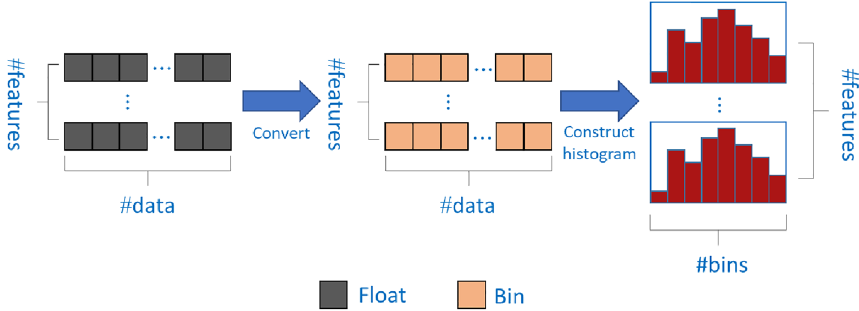
Figure 3. Histogram algorithm.